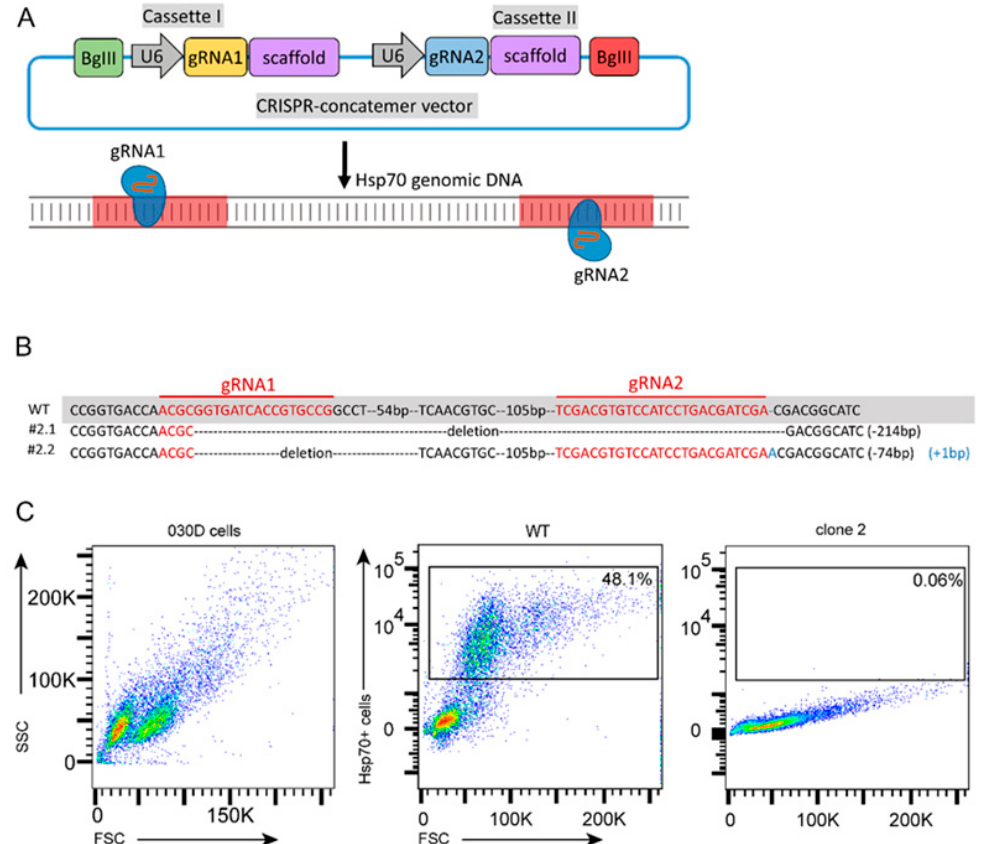
Figure 5. Generation and validation of Hsp70 knockout in cells of the 030D cell line. ( A ) Schematic diagram of the CRISPR-concatemer with 2 gRNAs and the targeting site of Hsp70 by guide RNAs (see Figure S3). ( B ) Sanger sequencing results of clone 2 (including two alleles) and alignment with wild-type 030D cell (-: deleted bases; + : inserted bases). ( C ) Flow cytometry analysis of knockout cell clones to evaluate the expression of Hsp70 in 030D cells under arsenite stress. Wild-type 030D cells under arsenite stress were used as positive control.